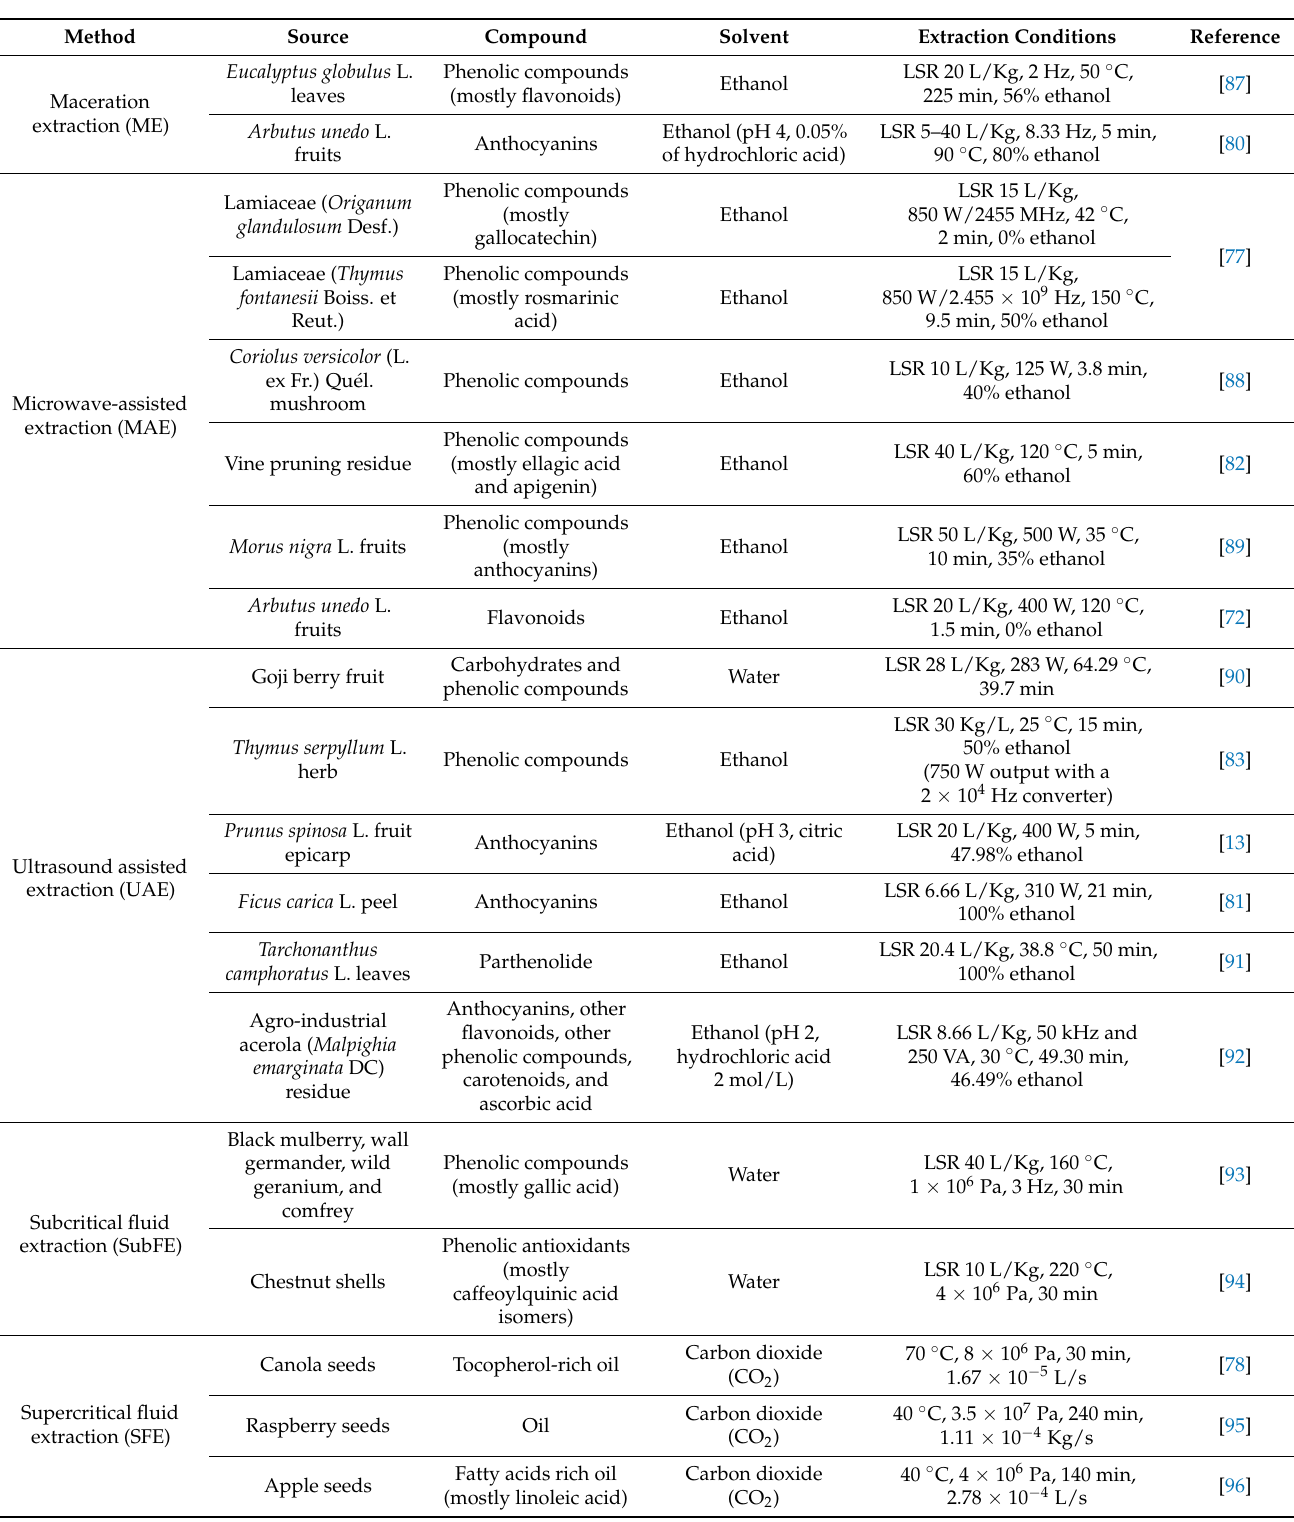
Table 2. Optimized green methods for the extraction of natural